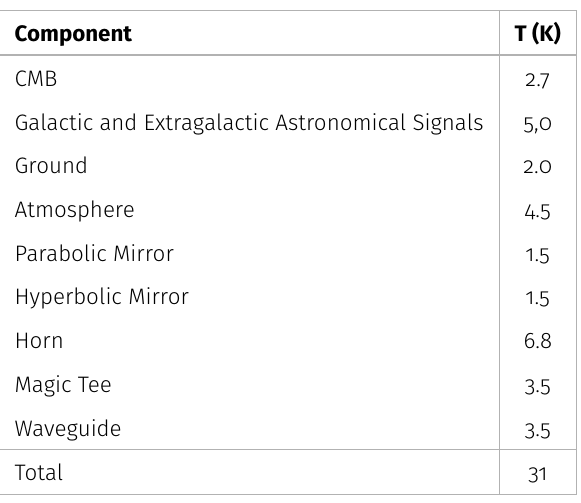
Table II. Temperature contributions of different